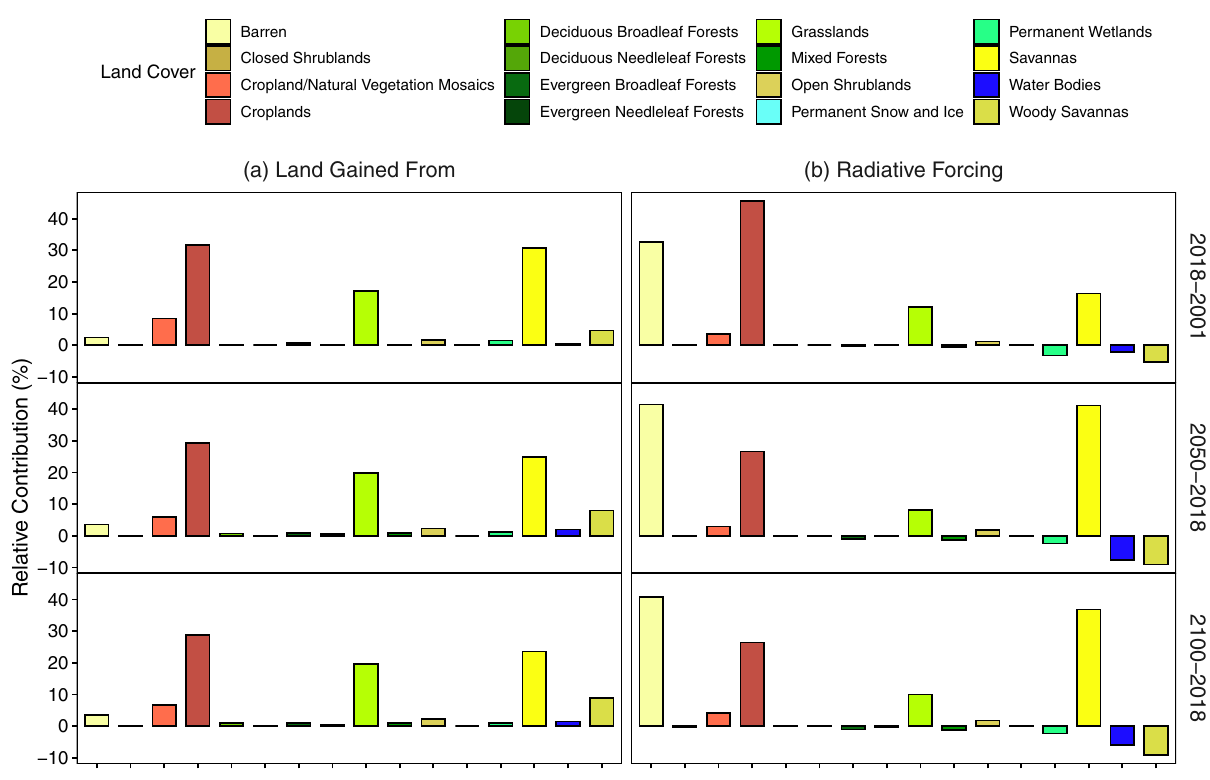
Fig. 4 Contributions of different land cover types to gained urban land and radiative forcing. a Contribution of different land covers to the global total new urban land areas; and b contribution of different land covers to the global total albedo-change-induced warming potential in 2018 relative to 2001(2018 – 2001), in 2050 relative to 2018 (2050 – 2018), and in 2100 relative to 2018 (2100 – 2018). Data for future periods are based on the SSP2- 4.5 scenario. Results of SSP1-2.6 and SSP5-8.5 scenarios are similar to that of SSP2-4.5 and are provided in Supplementary Figs. 5 and 6.